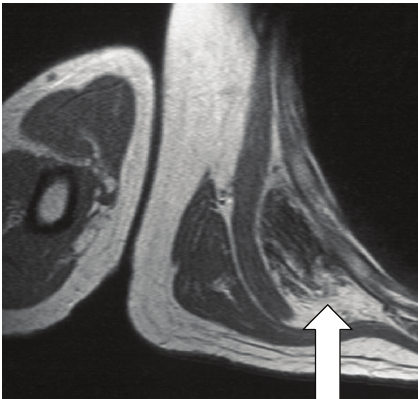
Figure 2: Axial T1-weighted MR image showing an elastofibroma as a soft tissue mass deep to the muscles and adjacent to the chest